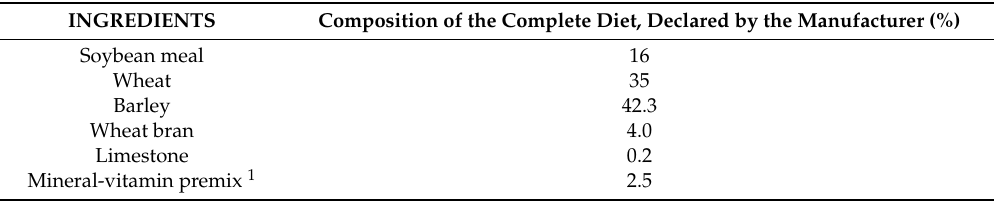
Table 4. Declared composition of the complete